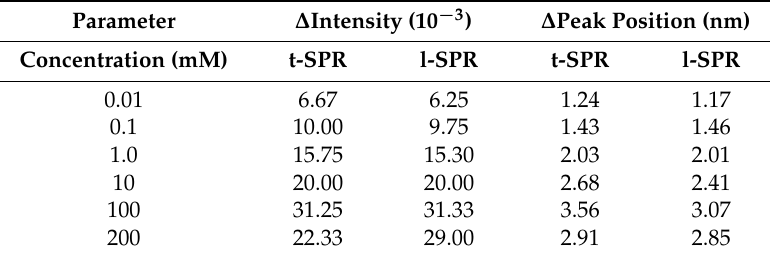
Figure 4. The plasmonic responses of transverse surface plasmon resonance (t-SPR) and longitudinal surface plasmon resonance (l-SPR) with the relationship between peak position and boric acid concentrations: ( A ) 200 mM, ( B ) 100 mM, ( C ) 10 mM, ( D ) 1 mM, ( E ) 0.1 mM, and ( F ) 0.01 mM boric acid. The dotted line represents the refractive index (RIU) of each boric acid concentration. * Refractive index for acid boric is 0.13339. Table 1. Summary for all changes in the SPR peak position and intensity.